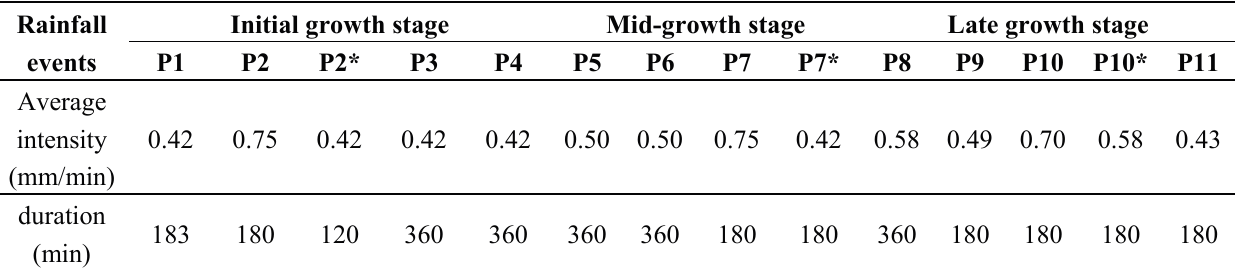
Table 1. Rainfall intensity and duration of the